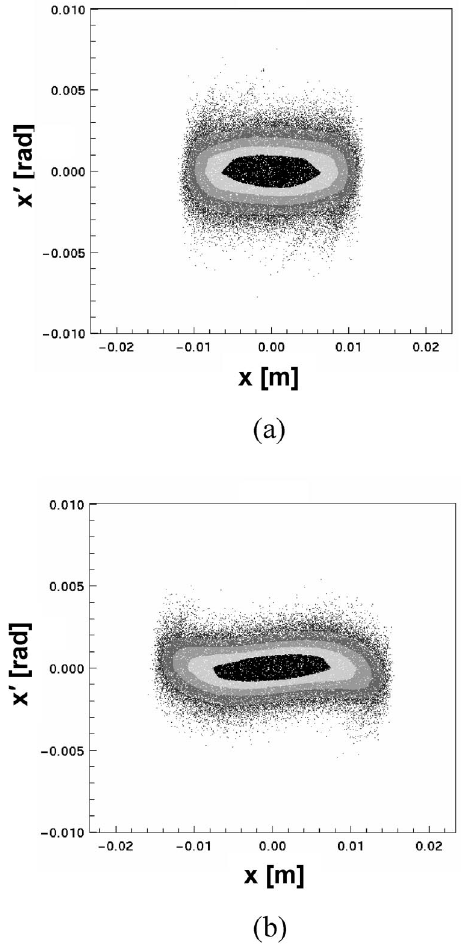
FIG. 8. Horizontal phase-space plots (simulations) in the HCX tank at the maximum beam excursion, where the beam fills (a) 60% and (b) 80% of the clear bore aperture. The physical aperture is at (cid:9) 23 mm